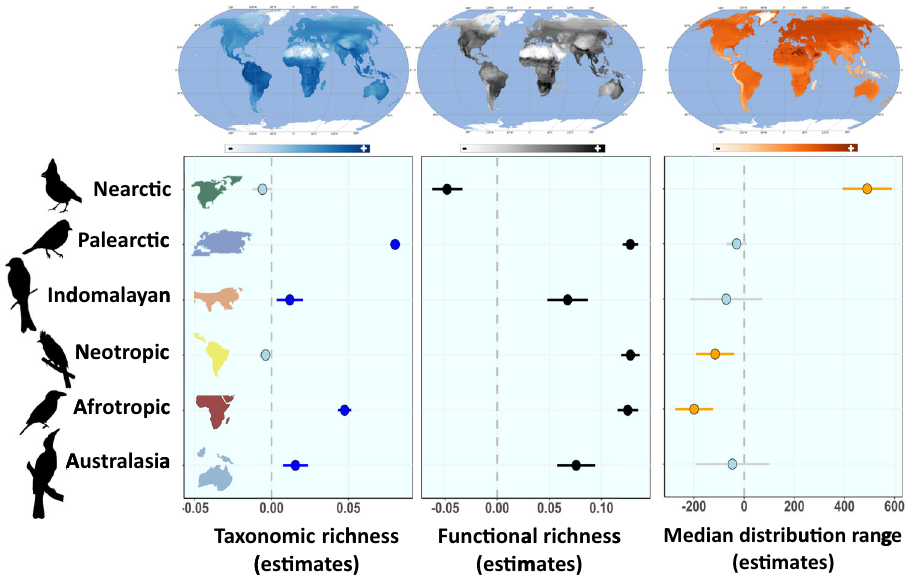
Fig. 4 | Effect of land-use diversity on bird regional taxonomic, functional richness, and median community distribution range. Circles represent esti- mated slopes (beta coef fi cient of linear trends ±95% CI) after accounting for the effect of primary productivity, for taxonomic richness (left panel, blue dots), functionalrichness(centralpanel,blackdots)andmediandistributionrange(right panel,orangedots).Non-signi fi canttrends(slopenodifferentfrom0)areshownin grey.Nearctic: n =2630gridcells.Neotropic: n =2262gridcells.Palearctic: n =6123